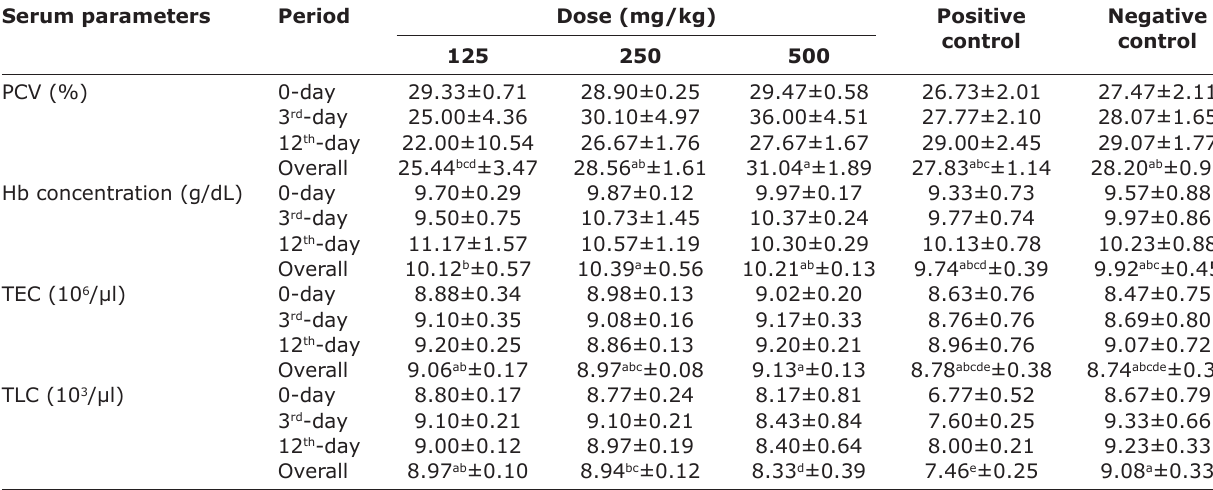
Table-3: Effect of I. tinctoria ethanolic extracton blood parameters (mean±SE) in sheep naturally infected with GI nematodes. Serum parameters